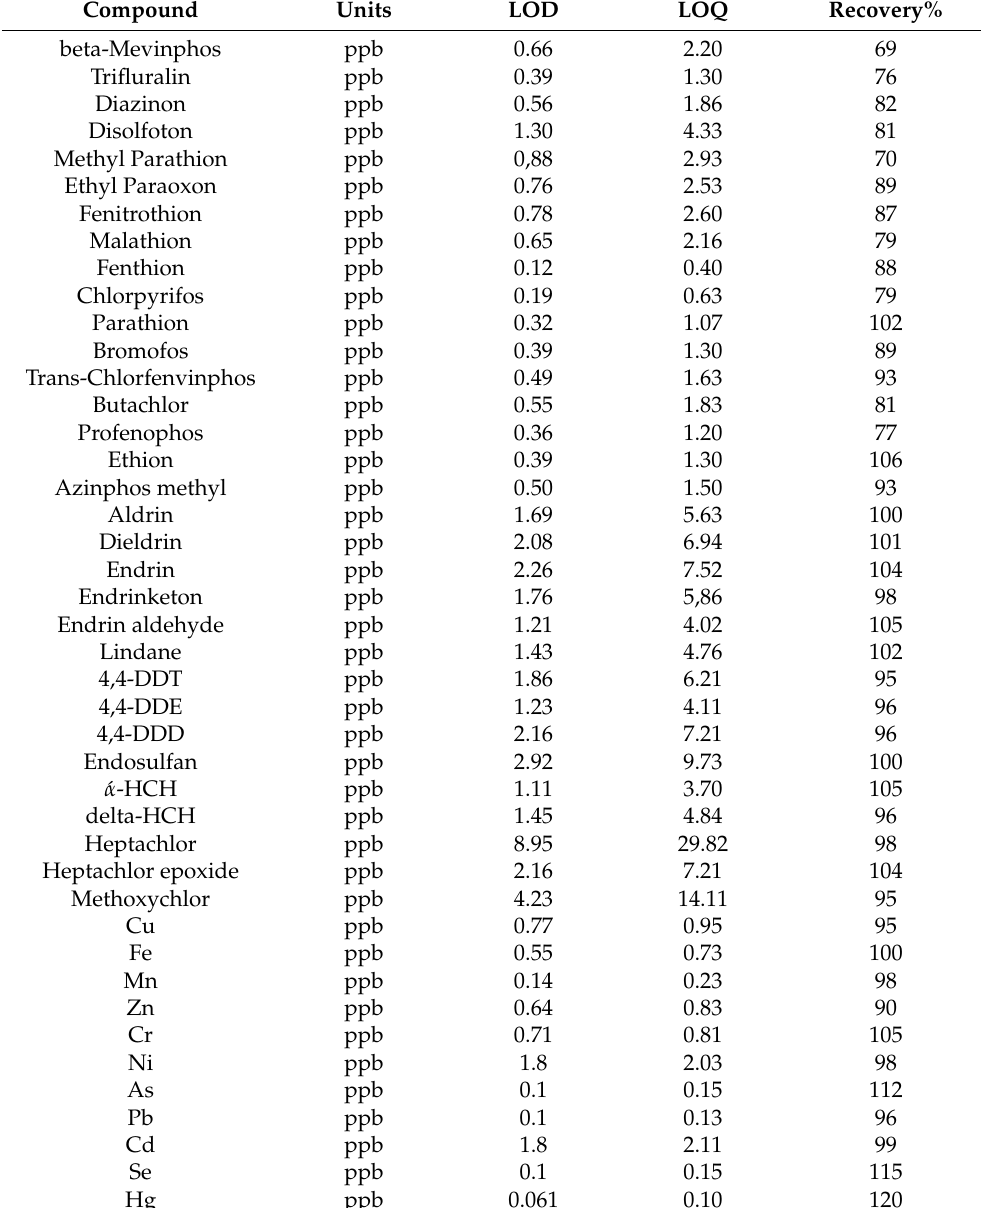
Table 1. Summary of QA-QC data for trace elements and pesticide